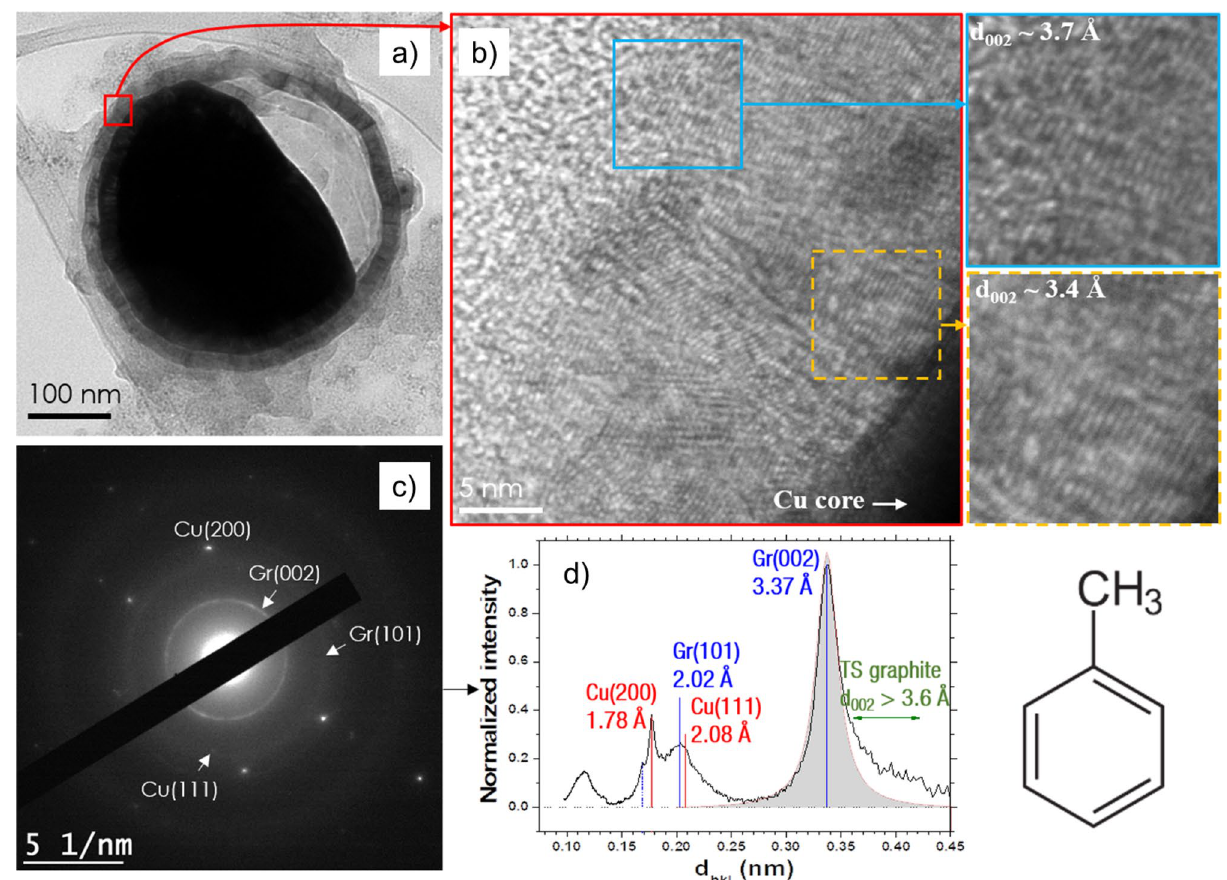
Figure 2. ( a ) High-resolution image of a submicronic particle synthesized by discharges in toluene. ( b ) HRTEM image of the red inset of ( a ). ( c ) SAED pattern from ( a ) exhibiting Cu (200) reflections and Gr (002) and (100) rings. ( d ) A radially integrated profile permits to highlight Cu (111) reflections. The dotted blue line corresponds to the second-order Gr (004)